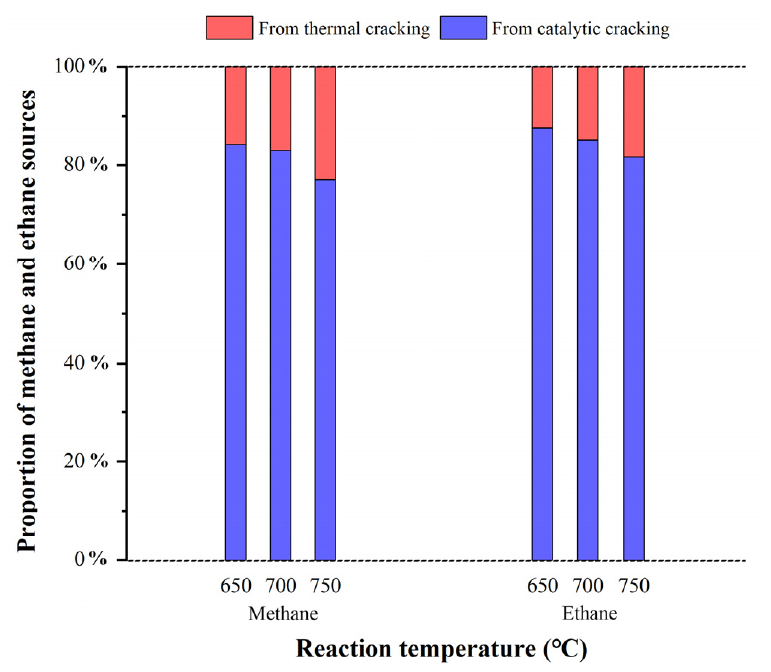
Figure 9. The proportion of methane and ethane derived from catalytic cracking and thermal cracking for pentene cracking over H-ZSM-5 at 650–750 ◦ C. Reaction conditions: total pressure, 130 kPa; partial pressure, 60 kPa; WHSV, 83 h − 1 .